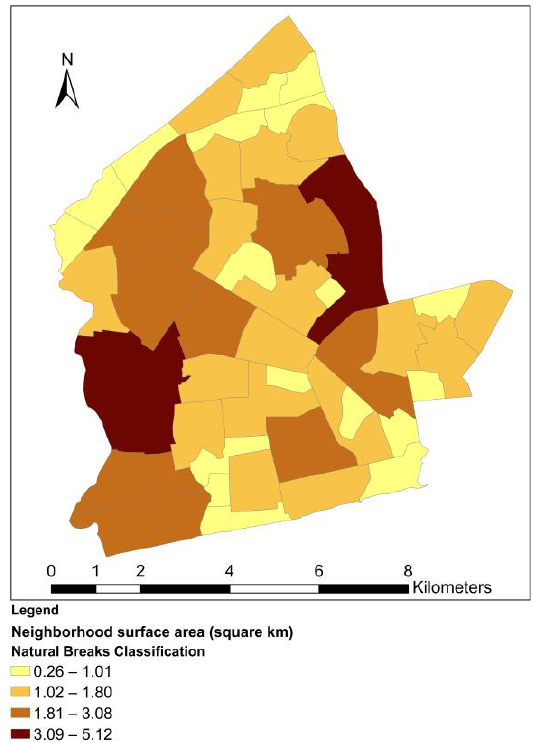
Figure 4. Distribution of neighborhood surface area.